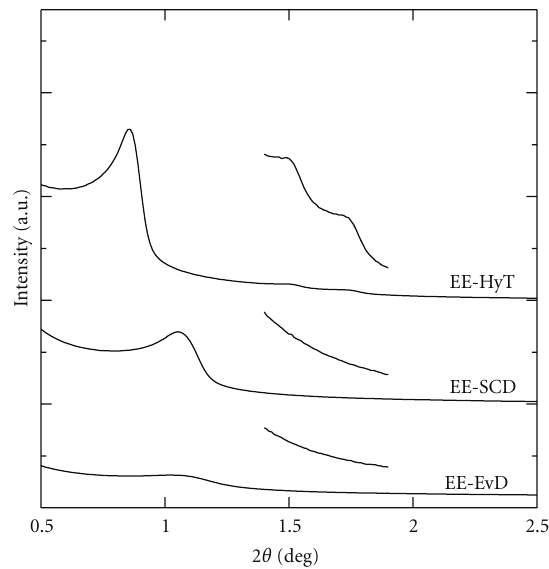
Figure 4: 29 Si CP/MAS NMR spectra of the ME-EvD, the ME-SCD, and the ME-HyT samples.